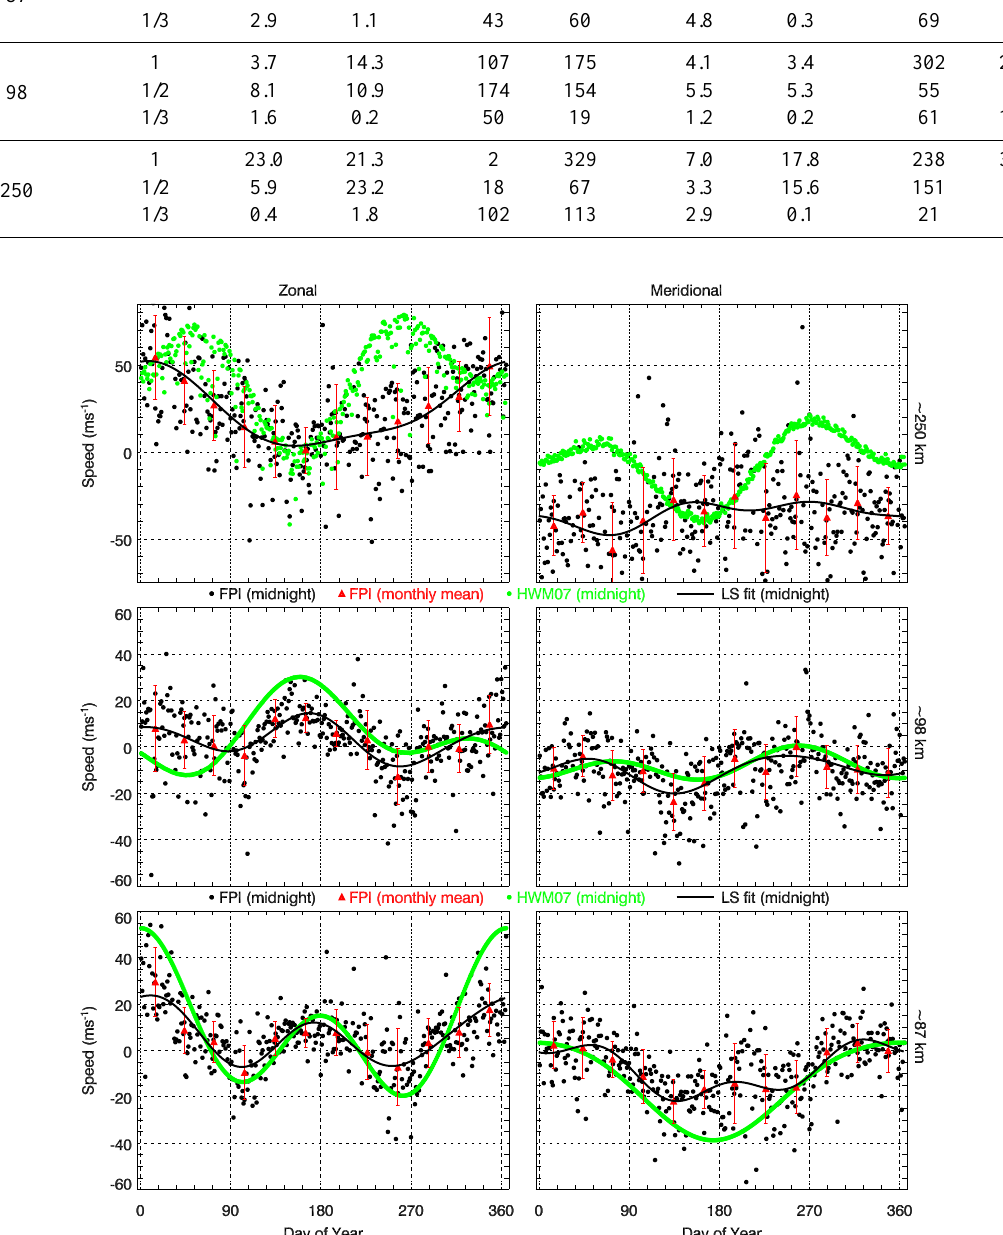
Fig. 4. Midnight zonal (eastward positive) and meridional (northward positive) winds obtained from FPI (black dot) and HWM07 (green line) at the altitudes of ∼ 87km (lower row), ∼ 98km (middle row), and ∼ 250km (upper row), respectively. The monthly averaged winds and their standard deviations are shown as red triangles and error